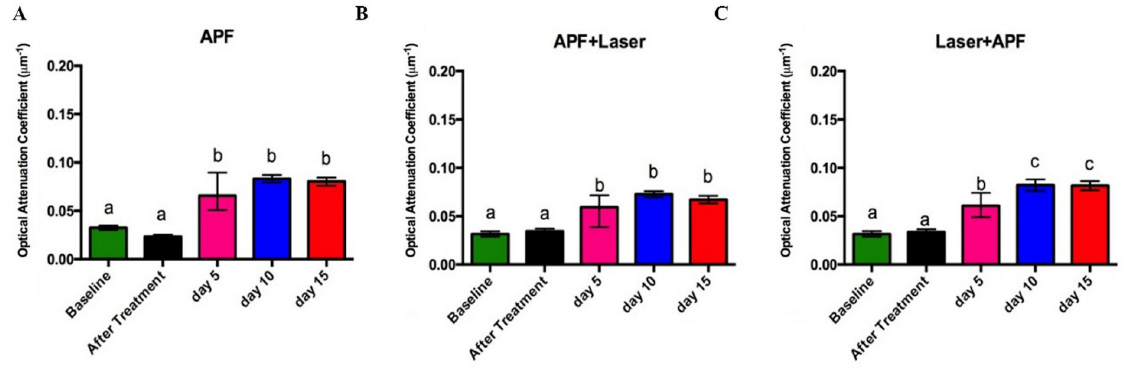
Fig 4. Average Optical Attenuattion Coefficient (OAC) obtained from the attenuation of the OCT signal of the samples over time. A) APF Group; B) APF+Nd:YAG Laser Group; C) Nd:YAG Laser+APF Group.